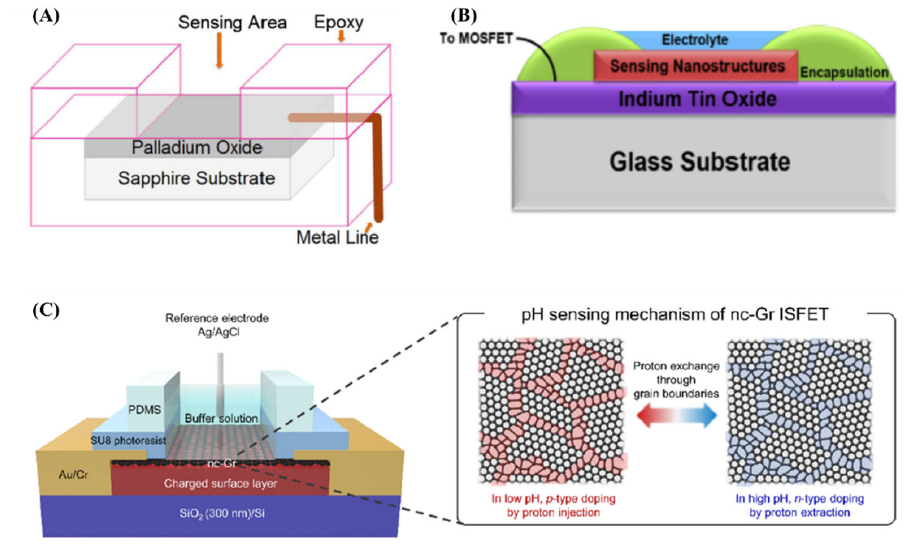
Figure 5. ( A ) Palladium oxide extended gate FET (reprinted from [95] with the permission